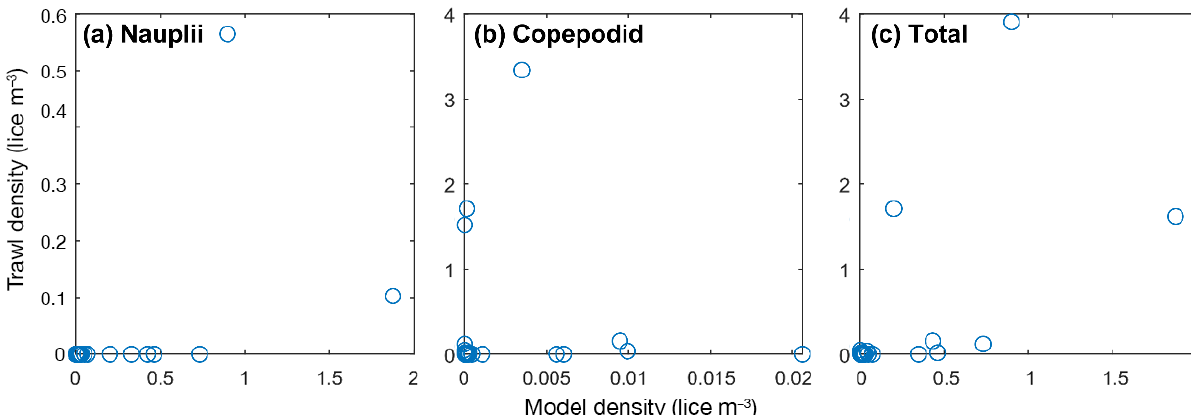
Fig. 7. Modelled sea lice ( Lepeophtheirus salmonis) density plotted against plankton trawl abundance for the 23 trawls col- lected during the simulated period, for (a) nauplii, (b) copepodids, and (c) all larval lice. Model densities are calculated within a 2000 m radius of the start location of a